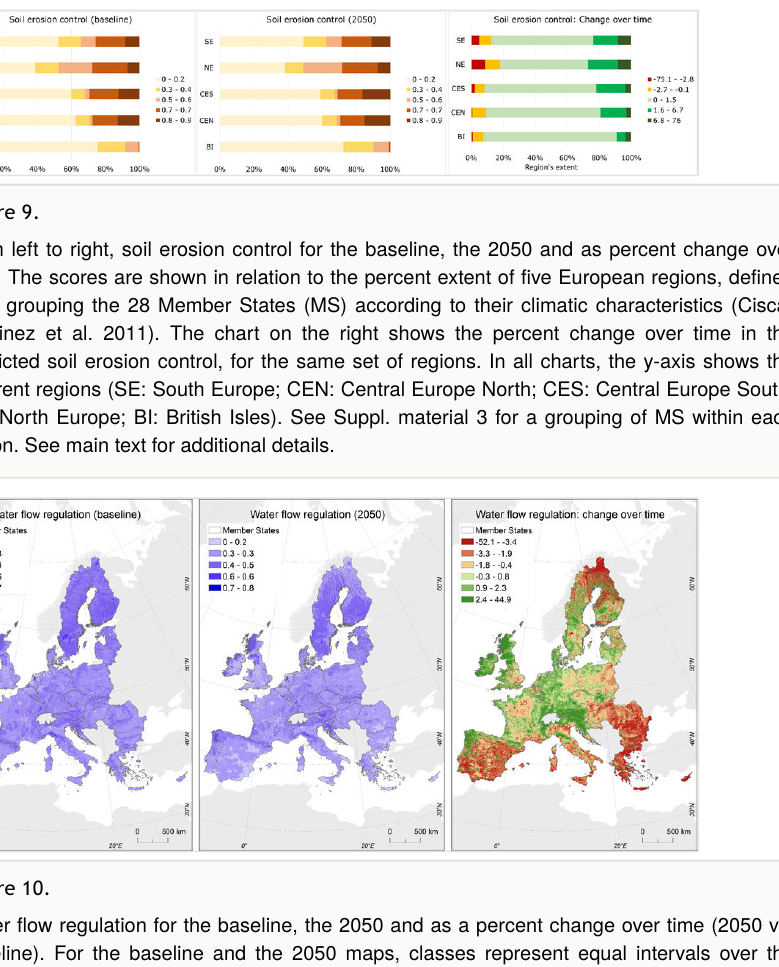
The map for the baseline water fl ow regulation did not show a spatial pattern in the distribution of scores, whilst the 2050 prediction showed some regions with greater capacity of regulating water fl ow (e.g. Northern part of the British Isles, vast areas in the EU-28 Scandinavian countries, Northern part of The Netherland and of Portugal, to give a few examples). The percent change between 2050 and the baseline showed that most of the values were within -3.4% and +2.4% change, with very few values towards the extreme ends (mean = -0.4 and SD = 6.3). The visual representation, therefore, was chosen to re fl ect this distribution. Extended areas of greatest negative change were located in the Northern-most part of the EU-28 Scandinavian countries as well as in the South-East part of Europe and